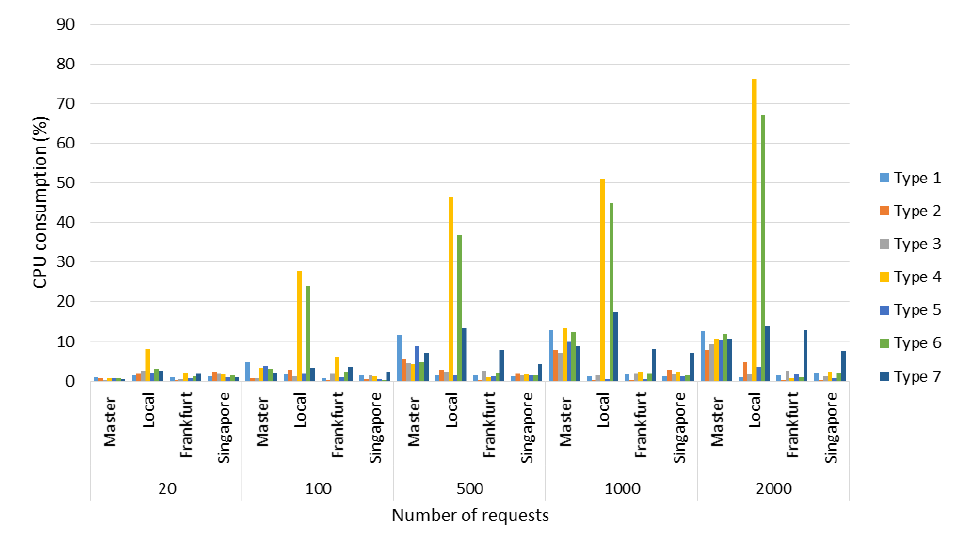
Figure 7. Average CPU consumption with respect to the numbers of connections.